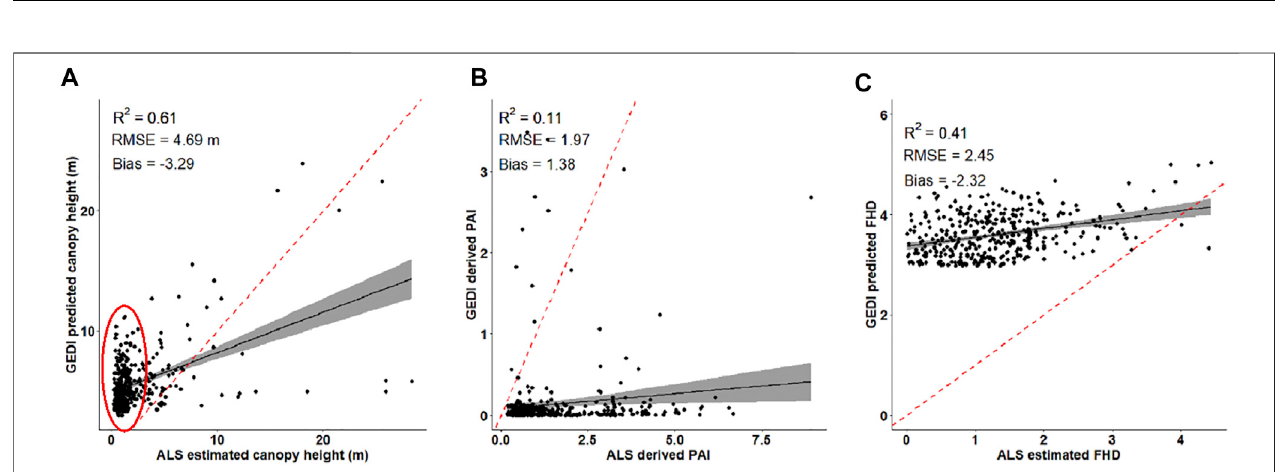
FIGURE 7 | Relationship between ALS and GEDI predicted functional traits, including: (A) canopy height, (B) plant area index (PAI), and (C) foliage height diversity (FHD). The solid lines represent the best fi t line while the gray areas are the 95% con fi dence interval. The red ellipse represents vegetation heights less than 2 m.